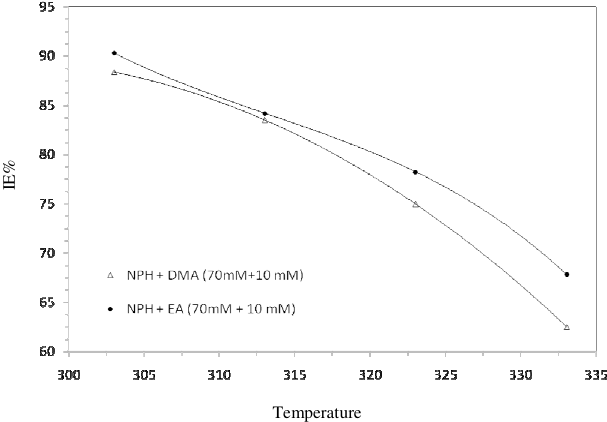
Figure 1. Variation of inhibition efficiency of the binary inhibitor mixtures with temperature at optimum concentration